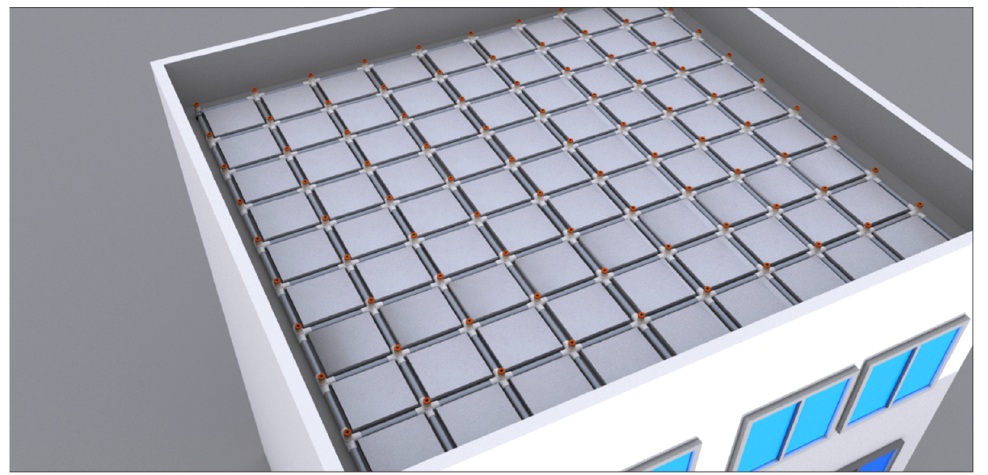
Figure 3. Filling the empty area between PVS tubes with polystyrene foam, expanded clay aggregate, or similar local lightweight aggregate (the same diameter as PVC pipe).